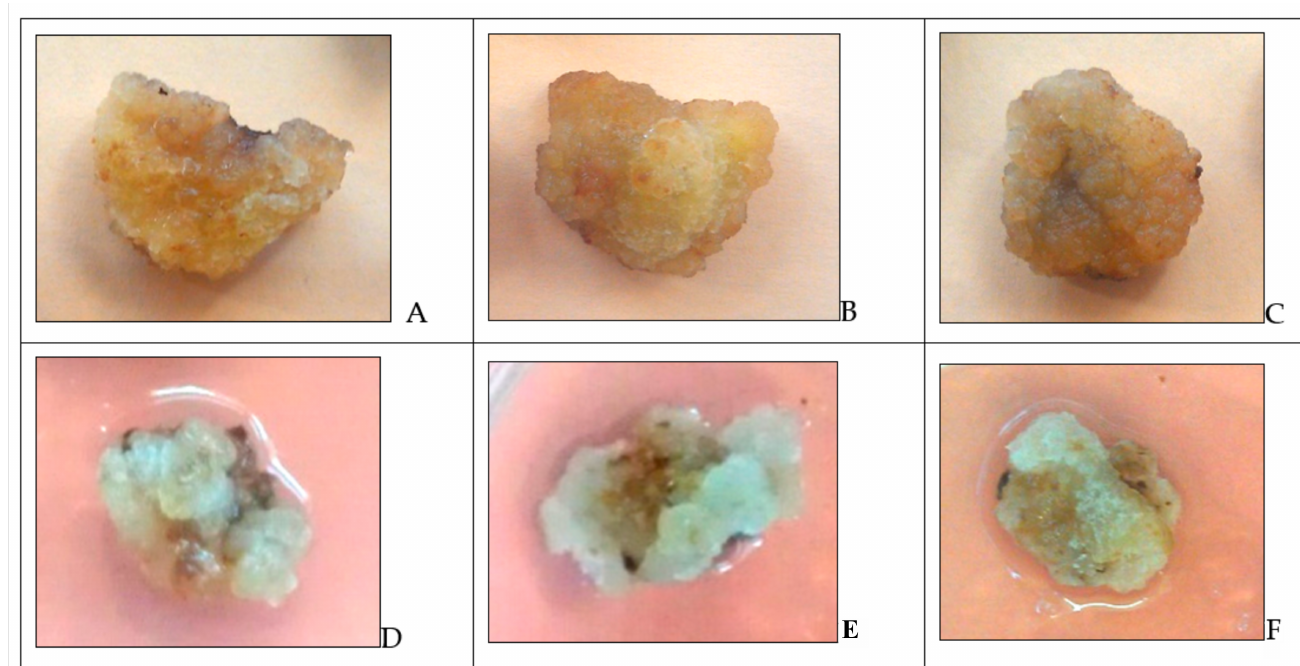
Figure 2. Tea callus culture at 24 days of age grown in the dark ( A – C ) or in the light ( D – F ) and kept in water ( A , D ) or 1 mM H 2 O 2 . ( A , D ) control; ( B , E ) short-term exposure to H 2 O 2 (2 h); ( C , F ) aftereffect of H 2 O 2 (after 48